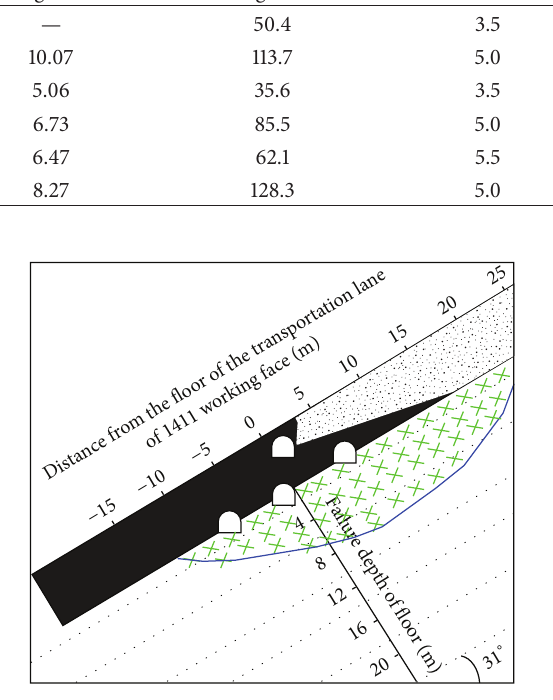
Figure 8: Failure curve of floor strata along the dip